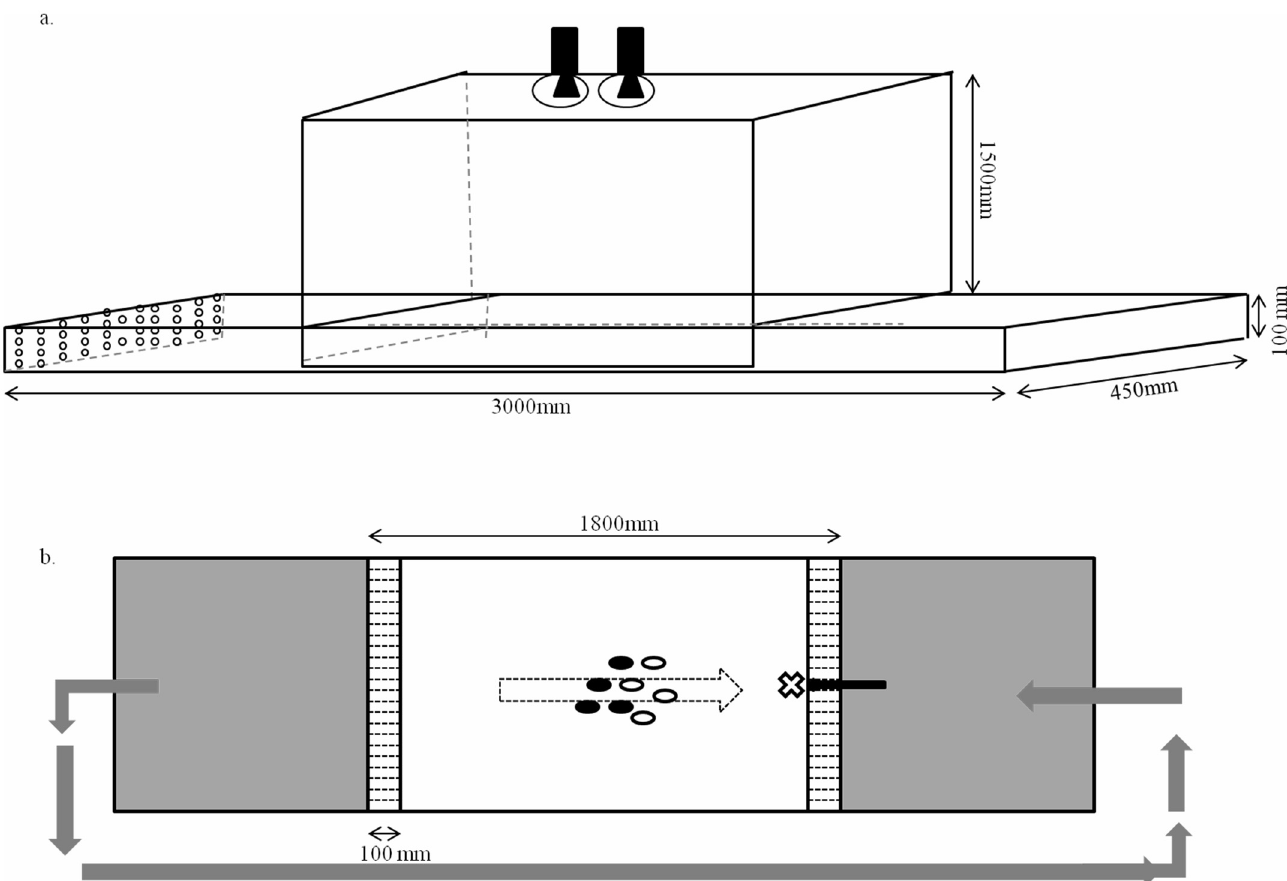
Fig 1. Diagram of the experimental arena, a rectangular flow tank showing a.) its dimensions and the positions of cameras sitting upon the custom made metal frame and b.) the direction of water flow, the location where food items were released from the hose (X) and the dimensions of the area of water accessible to fish defined by the Corflute 1 barriers. The dotted arrow shows the angle of orientation of the shoal into the current and the fish are identified as food-deprived (white ellipses) and well-fed (black ellipses).